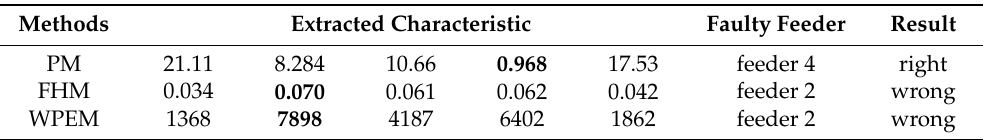
Table 2. Comparison results between the proposed method (PM) and FHM and wavelet packet energy